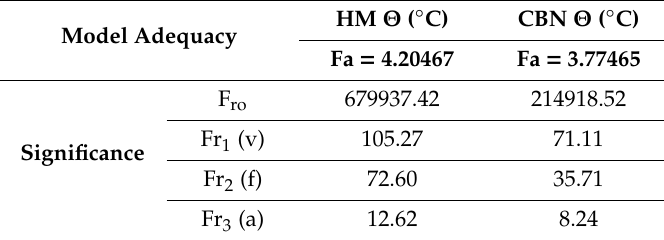
Table 5. Adequacy of models and significance of